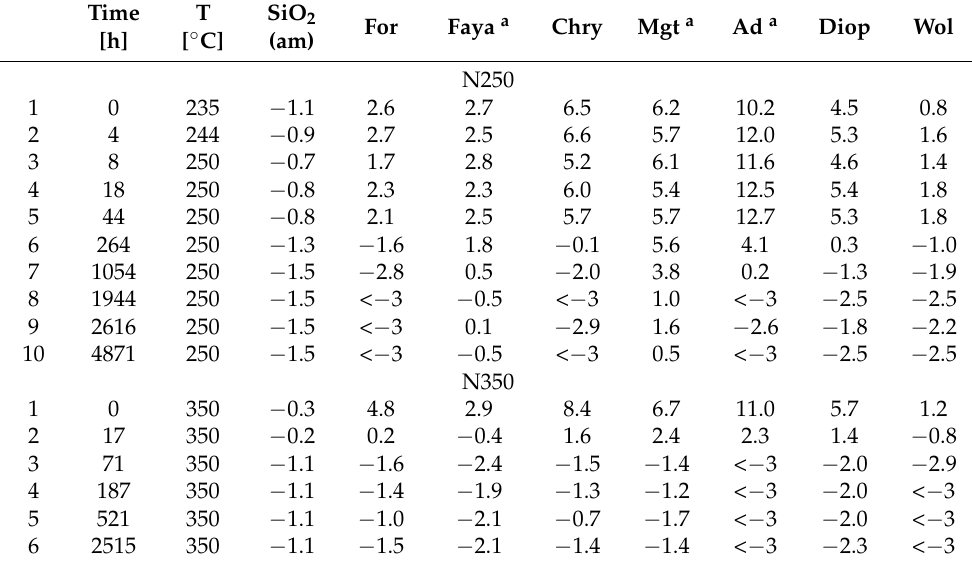
Table 6. Saturation indexes of selected solid materials co-existing with fluids from experiments in the komatiite–H 2 O–NO 3– system.